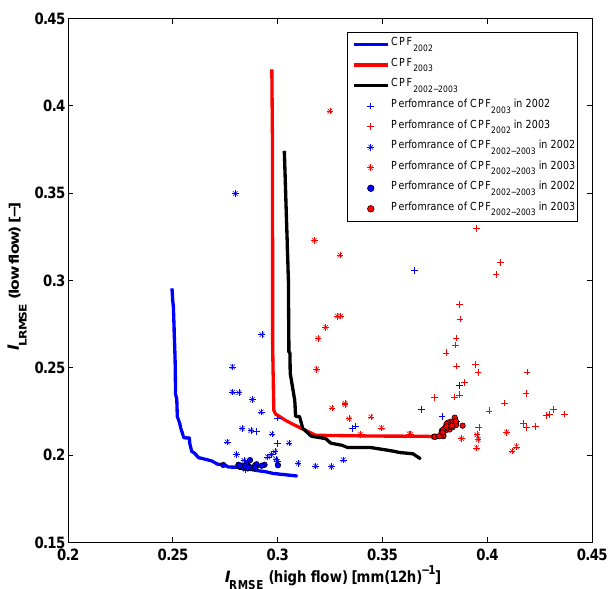
Fig. 5. The two-dimensional minimum distance Pareto front (red dots) based on year 2002–2003 (MDPF 2002 − 2003